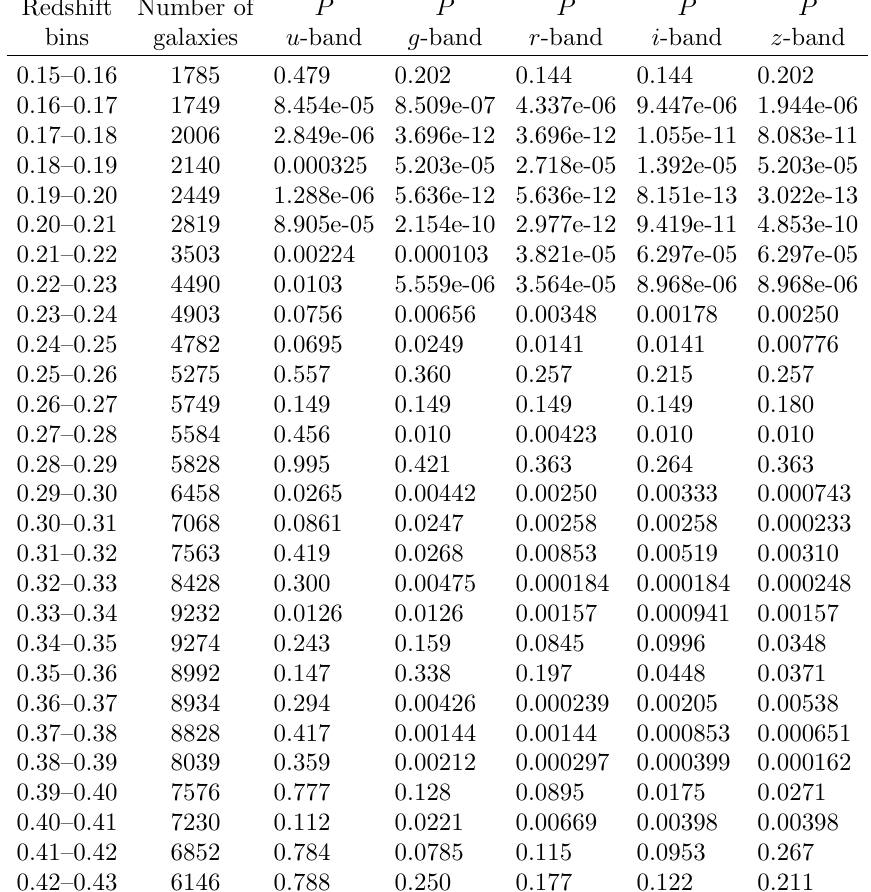
Table 1. KS probabilities of five band luminosities, where two samples at both density extremes are drawn from the same